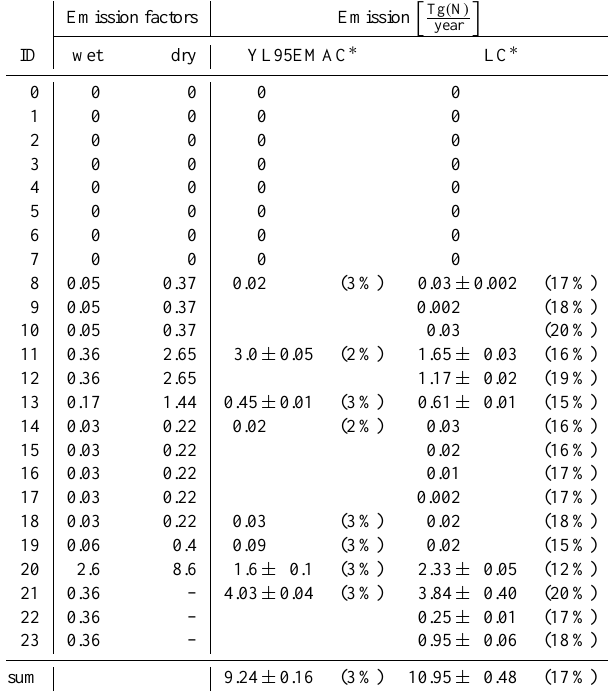
Table 2. Measured and simulated SNO x for the YL95EMAC ecosystems (in ngm − 2 s − 1 ). Measurements are taken from our compilation (numbers per ecosystem in brackets) and the simulated SNO x values are for the corresponding period of each simulated year.